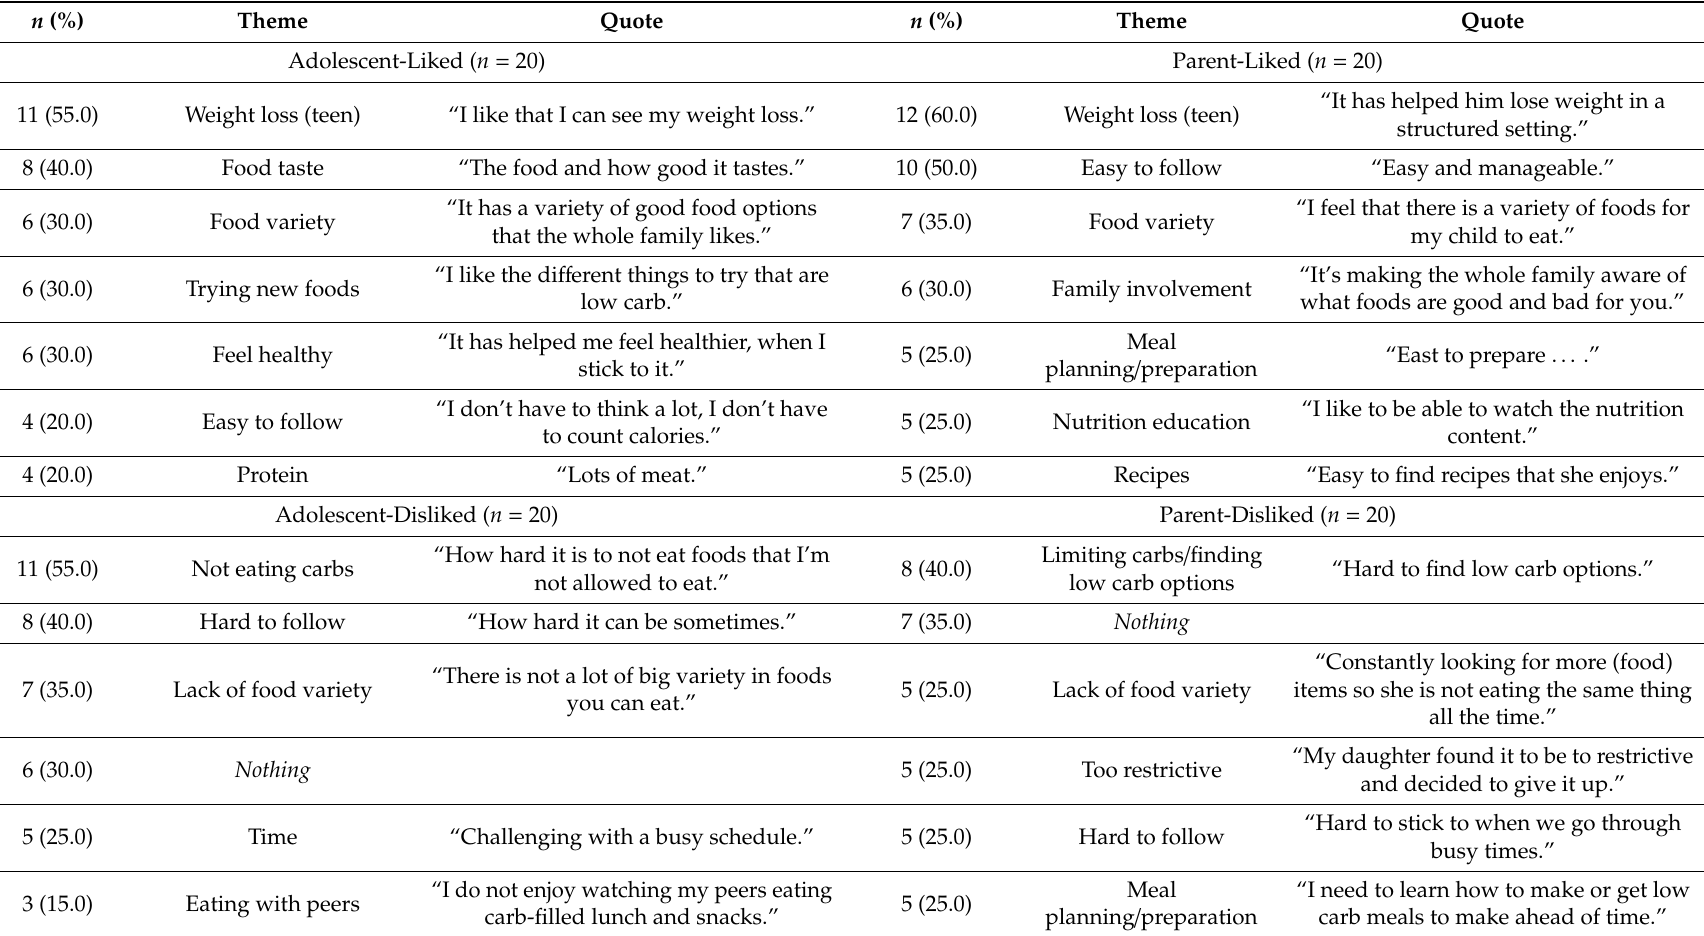
Table 5. Adolescent and parent open-ended